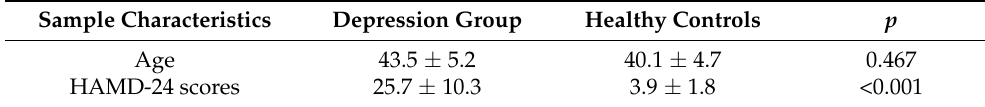
Table 1. Sample characteristics of the studied groups.